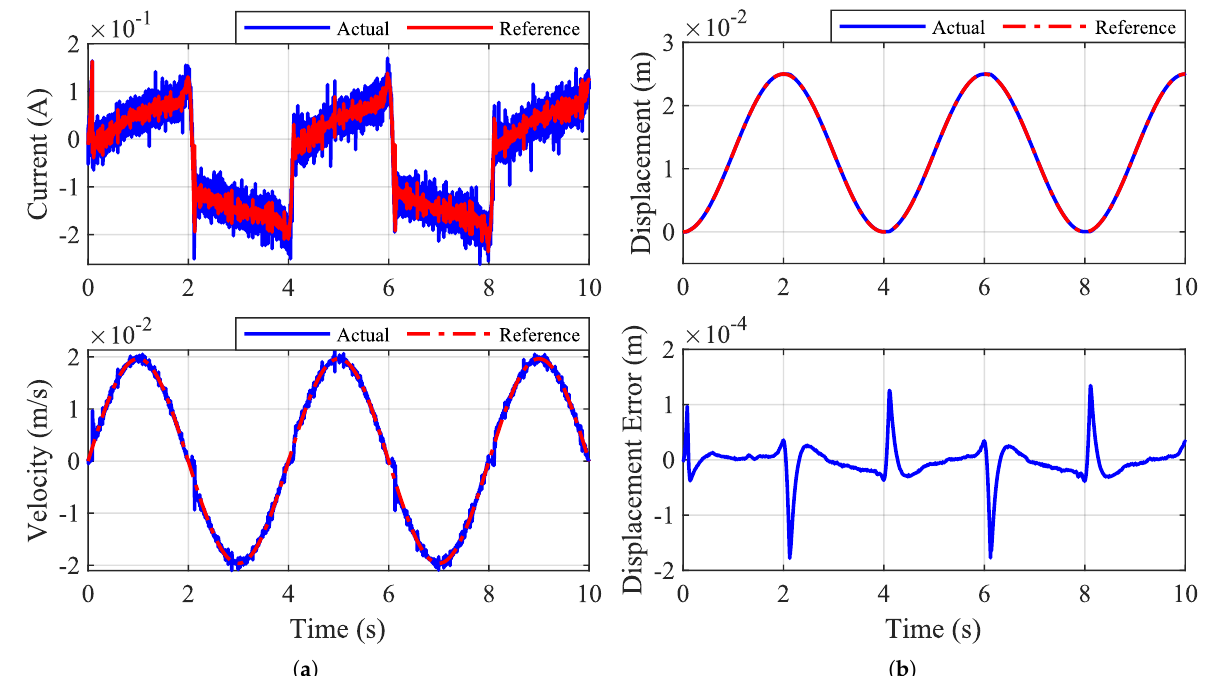
Figure 11. Experimental waveforms for sinusoidal position tracking at 0.25 Hz with α = 5, K v = 20, K p = 40. ( a ) Current and velocity; ( b ) displacement and displacement error.